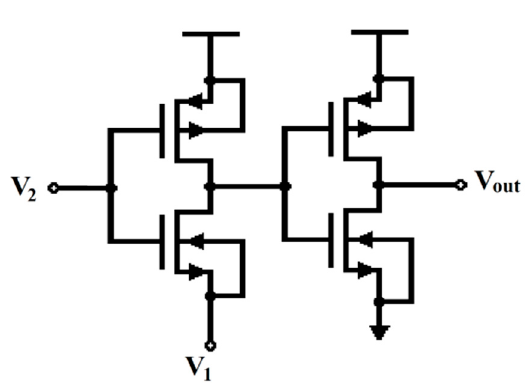
Figure 24. 01-generator circuit.